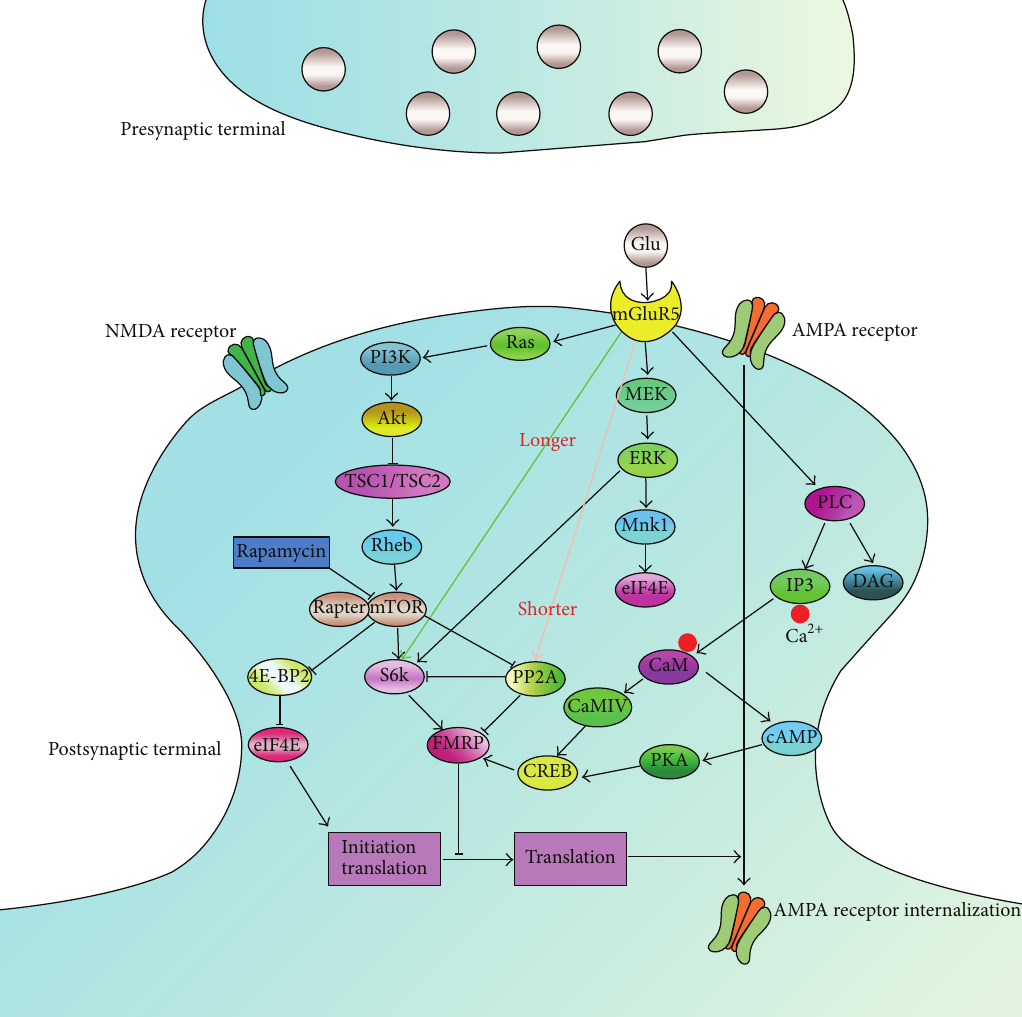
Figure 1: Signaling pathways downstream of Group I mGluR stimulation. There are three signaling pathways downstream of mGluR5 affecting translation: the typical PLC cascade reaction, the MEK-ERK-Mnk1, and the PI3K-mTOR pathway. Activation of mTOR is one of the primary triggers for the initiation translation via phosphorylation of 4E-BP and S6K. After stimulation of mGluR5, PI3K phosphorylates the membrane phospholipid PIP2, converting it to PIP3. PIP3 recruits Akt to the membrane and then Akt activates mTOR by inhibiting TSC. Subsequently, mTOR interacts with Raptor, which binds both 4E-BP and S6K. Phosphorylation of S6 and 4E-BP finally results in mRNA translation. ERK is a point of convergence of several signaling cascades. Several FMRP target mRNAs (PP2A and PI3K) are members of second messenger cascades converging on ERK. ERK phosphorylation is regulated by phosphatases such as PP2A. In fmr1 -KO mice, PP2A is overactivated after mGluR5 stimulation, causing the rapid deactivation of ERK. The Ca 2+ stored by IP3 release leads to activation of Ca 2+ -calmodulin (CaM) dependent pathways, including AC1-cAMP dependent protein kinase (PKA) and CaMKIV, which were stimulated by CaM and then phosphorylate CREB. Phosphorylated CREB initiates the CREB-dependent transcription of fmr1 gene and upregulates FMRP. MEK, mitogen-activated protein kinase kinase; ERK, extracellular signal regulated kinase; Mnk1, mitogen-activated protein kinase interacting serine/threonine kinase 1; PI3K, phosphoinositide-3 kinase; 4E-BP, 4E-binding protein; S6K, S6 kinase; PIP2, phosphatidylinositol 4,5-bisphosphate; PIP3, phosphatidylinositol (3,4,5)-trisphosphate; TSC, tuberous sclerosis complex; GAP, GTPase-activating